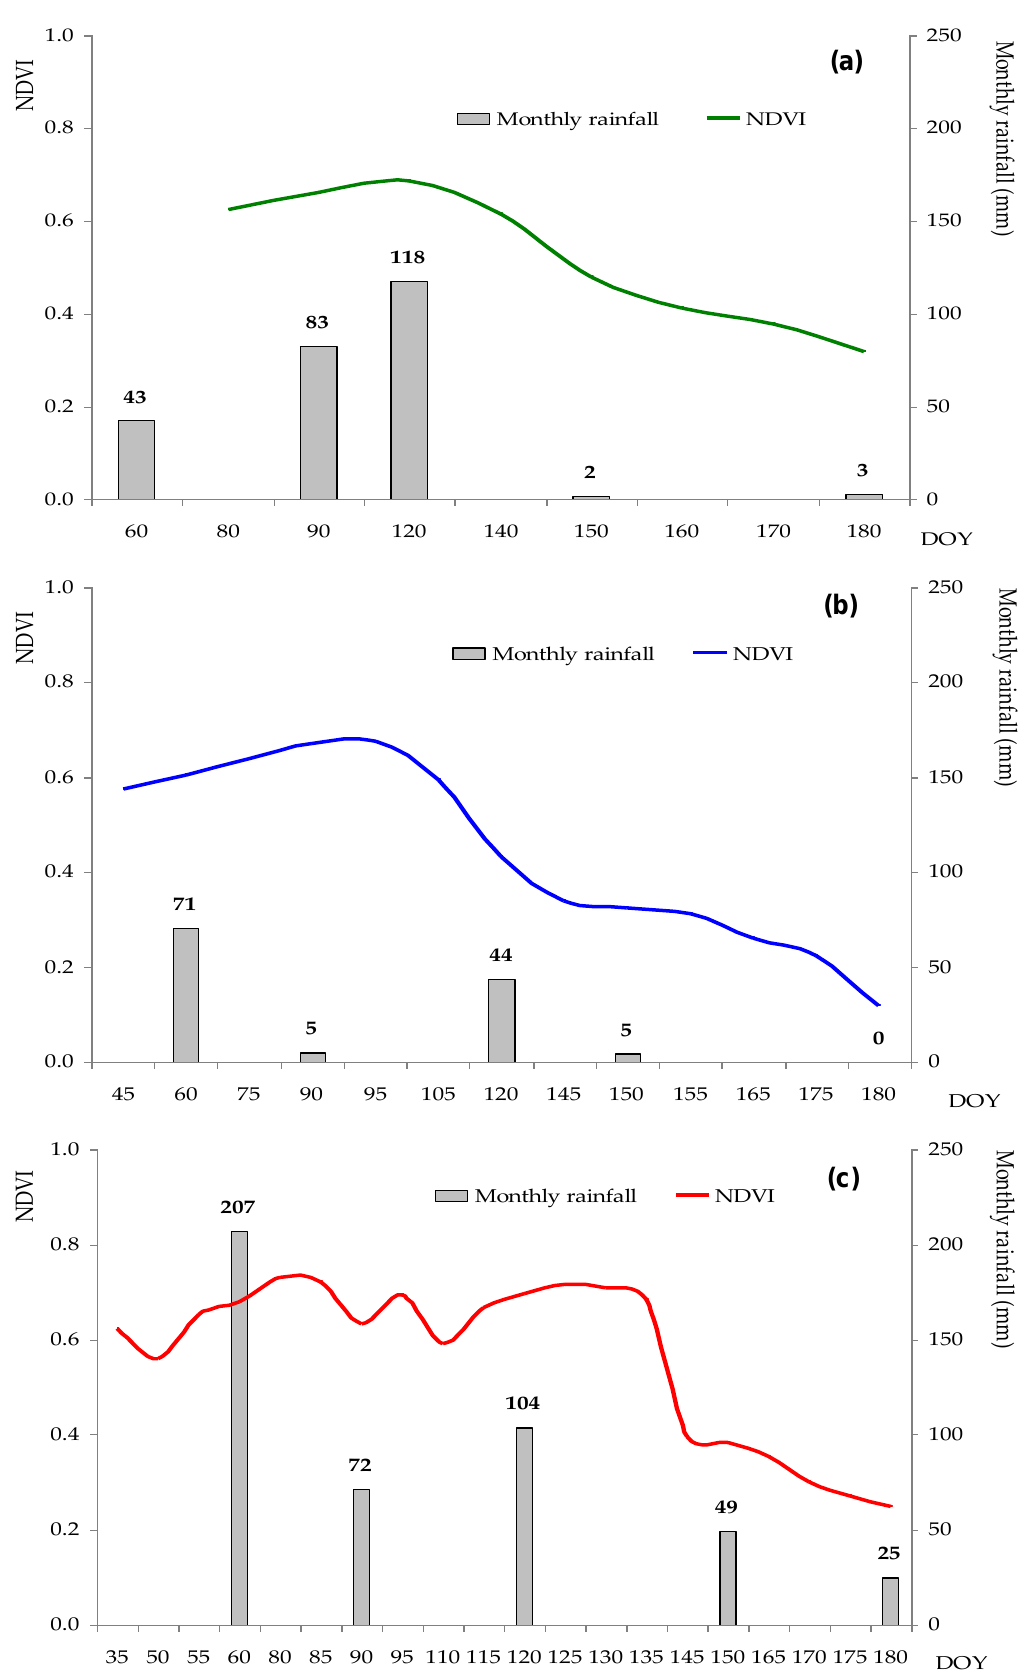
Figure 7. Accumulate monthly rainfall and vegetation index time series obtained by satellite images (NDVI SAT ) between February and June 2016 ( a ), 2017 ( b ), and 2018 ( c ).